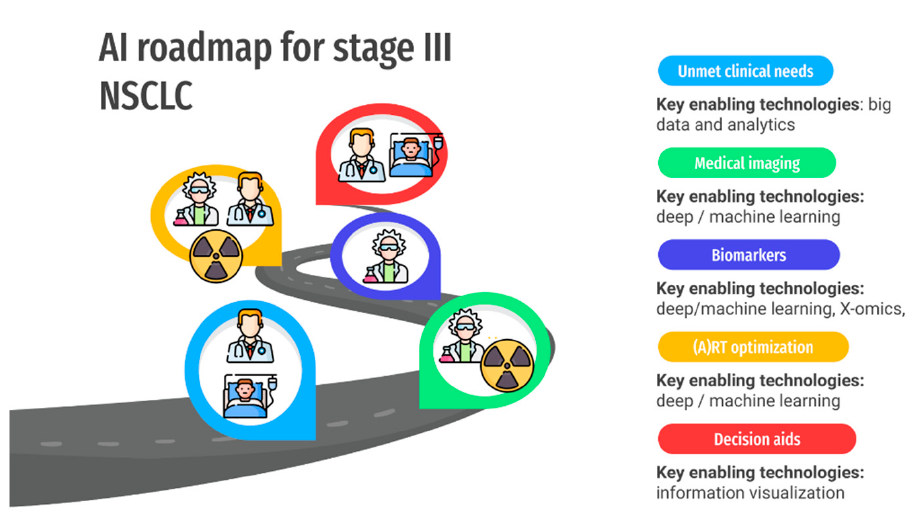
Figure 1. An overview of the critical points and key enabling technologies for the application of AI technologies to improve the current IGART workflow in the management of LA-NSCLC patients. Each of the critical points includes different stakeholders who need to be involved for a productive and collaborative environment. The structure of this review follows the progression of this figure.